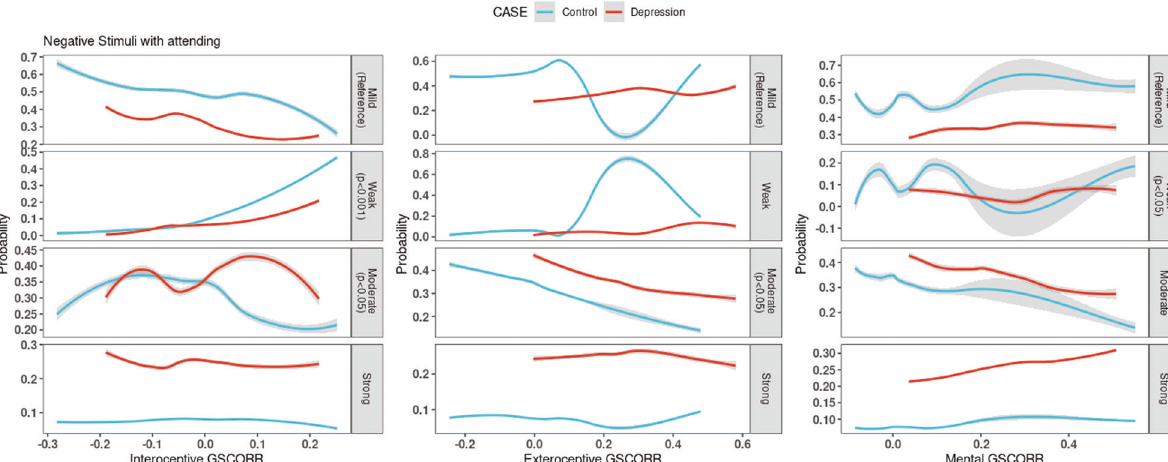
Fig. 4 Probability of Emotional response according to GSCORR while attending the negative stimuli. The x -axis shows GSCORR value while the y -axis shows probability of emotional response relative to the reference. Signi fi cant or marginal results are highlighted in gray tabs with respective p values. Blue color represents healthy controls while red represents MDD subjects. Increase in interoceptive self GSCORR increases the relative risk ratio of weak and moderate responses compared to mild (First column). When exteroceptive self GSCORR increases, the probability of moderate emotional response decreases compared to mild (second column). When mental self GSCORR increases, the probability of a weak emotional response decreases (third column). Overall, being in MDD group increases the probability of moderate or strong emotional response (as distinguished from mild and weak